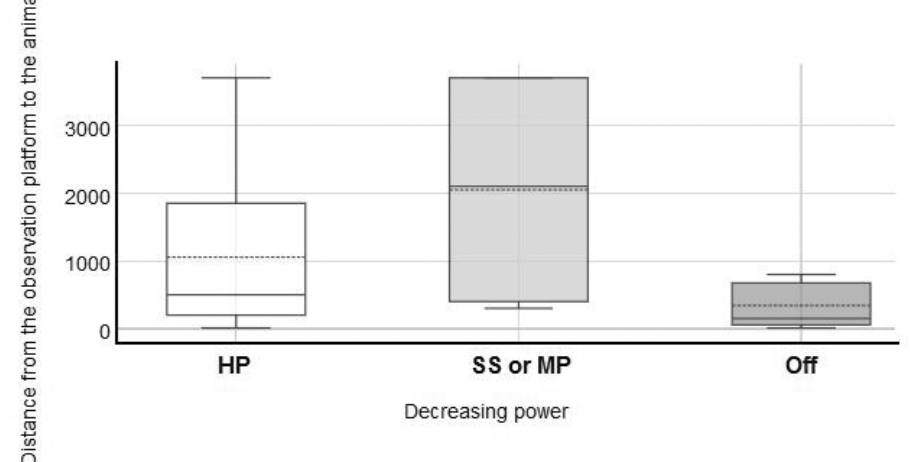
Figure 8. Distance sighting in relation to airguns power. HP=high power; SS= soft start; MP= medium power; Off= source